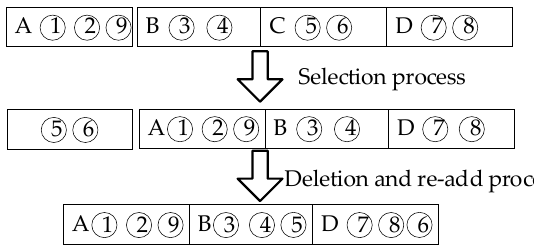
Figure 5. The process of the mutation operation.